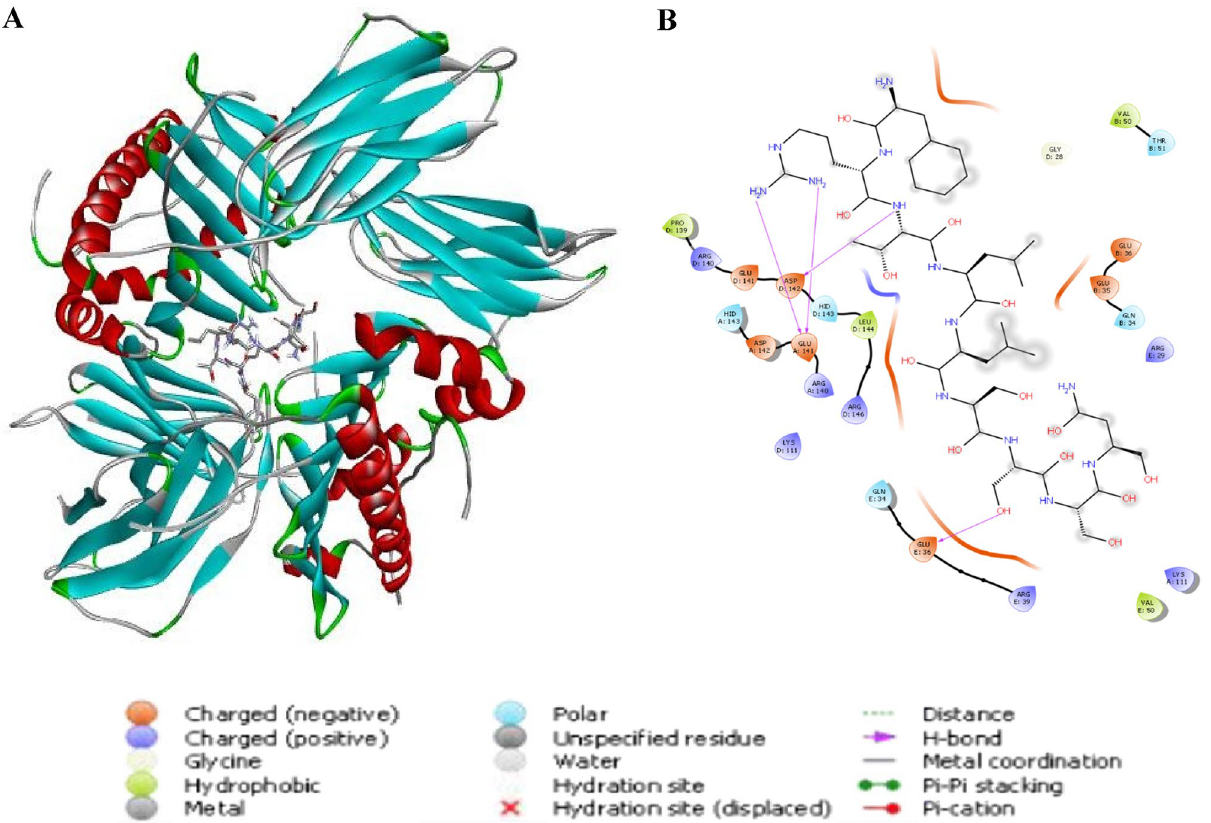
Figure 9. Representive view for Docking analysis of the predicted epitope YVLSTIHIY with HLA-DRB1 ( A ) 3D view, ( B ) 2D